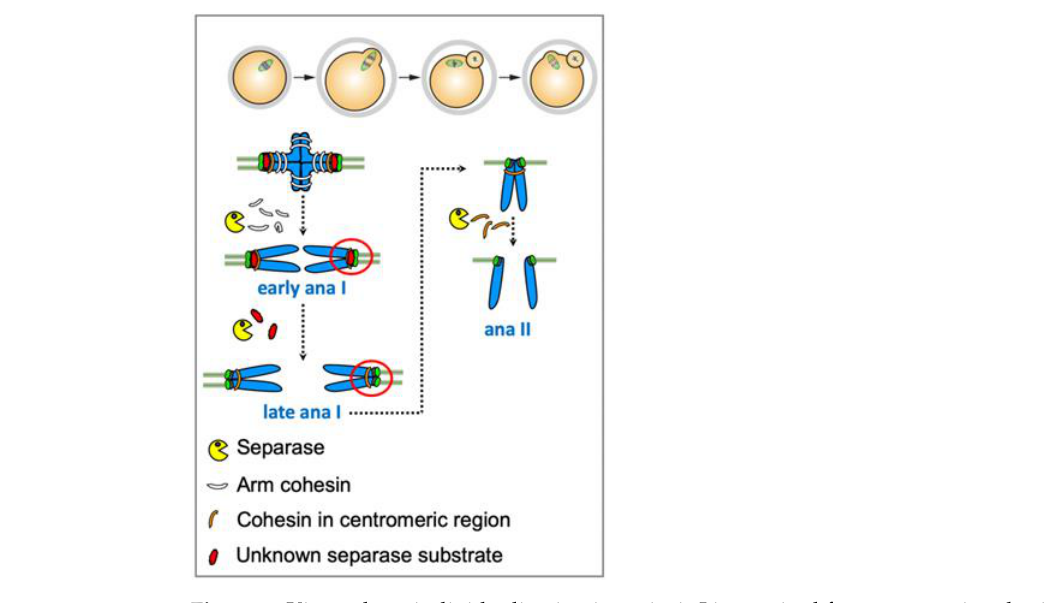
Figure 3. Kinetochore individualization in meiosis I is required for centromeric cohesin removal in meiosis II. Arm cohesin removal at the metaphase-to-anaphase transition in meiosis I is followed by separase-dependent removal of the physical connections holding sister kinetochores together as one unit. The protein(s) fusing sister kinetochores together that has/have to be cleaved in anaphase I is still unknown. Separase-dependent cleavage giving rise to the individualization of sister kinetochores (indicated with a red circle) is a prerequisite for cleavage of pericentromeric cohesin in meiosis II. Artificially introduced paired chromosomes in meiosis II segregate into chromosomes and not sister chromatids, but only when there was no prior sister kinetochore individualization.